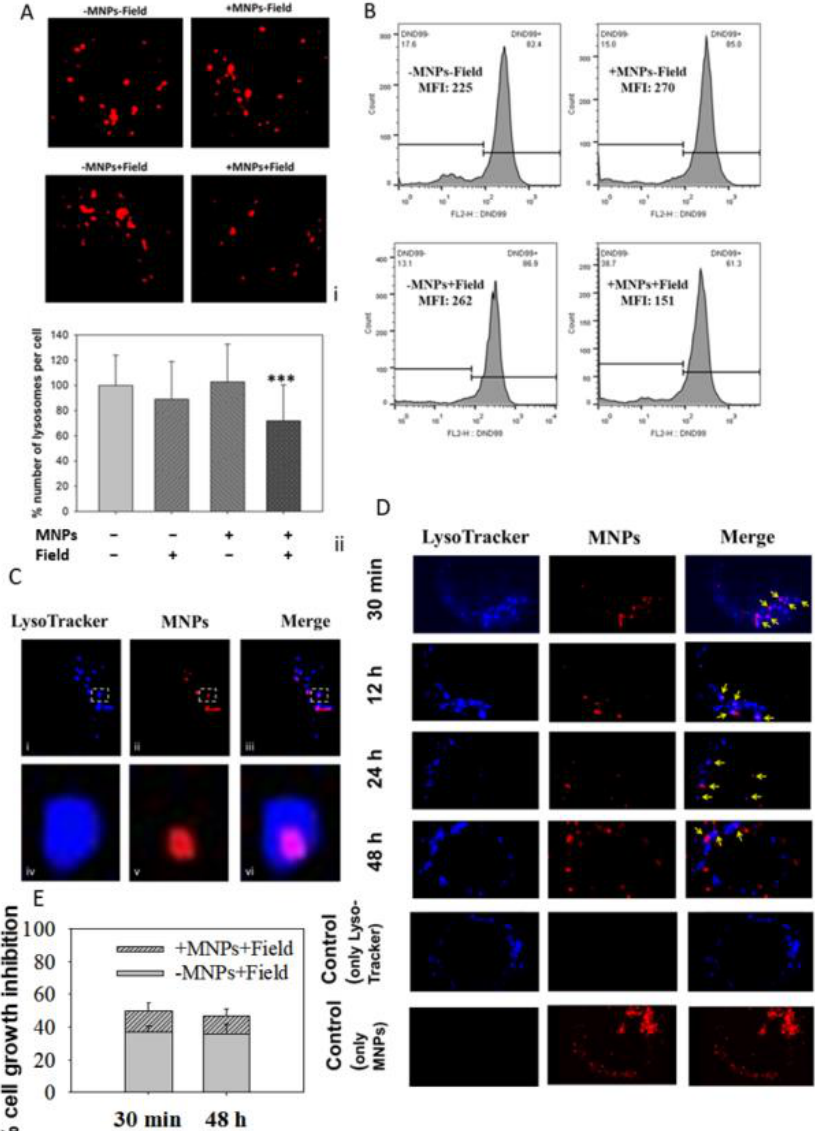
Figure 5. Effect of magnetomechanical stress on lysosomes. ( A ) Fluorescence microscopy of ± MNPs ± Field HT29 cells; lysosomes are stained red with the Lysotracker Red dye ( i ). ( ii ) Relative quantification of the number of lysosomes per cell expressed as % of the number counted in control ( − MNPs − Field) cells. ( B ) Flow cytometry representative histograms of HT29 cells stained with Lysotracker Red. Median fluorescence intensity (MFI) values indicate the relative degree of Lysotracker fluorescence and, hence, the acidity level of lysosomes in various treatment groups. Fluorescence microscopy and flow cytometry analyses were conducted 2 h after magnetic field exposure. *** Asterisks indicate a statistically significant difference (Student’s t -test, p ≤ 0.001). ( C ) Co-localization of lysosomes stained with Lysotracker Blue and fluorescently labeled MNPs (red). ( D ) Time-dependent co-localization of lysosomes and MNPs. Fluorescence images were taken at various co-incubation time points of HT29 cells with MNPs. Lysotracker Blue dye was used to visualize the lysosomes, and fluorescently tagged MNPs (red) were used for the incubation (100 μg /mL). Yellow arrays indicate co-localized MNPs and lysosomes. ( E ) Effect of MNPs co-incubation period on induced cell growth inhibition. HT29 cells were treated with MNPs (100 μg /mL) for 30 min or 48 h and/or exposed to a static magnetic field of 200 mT. Cell growth was analyzed 48 h post magnetic field exposure with the SRB assay. Values represent the mean ( n = 3) ±